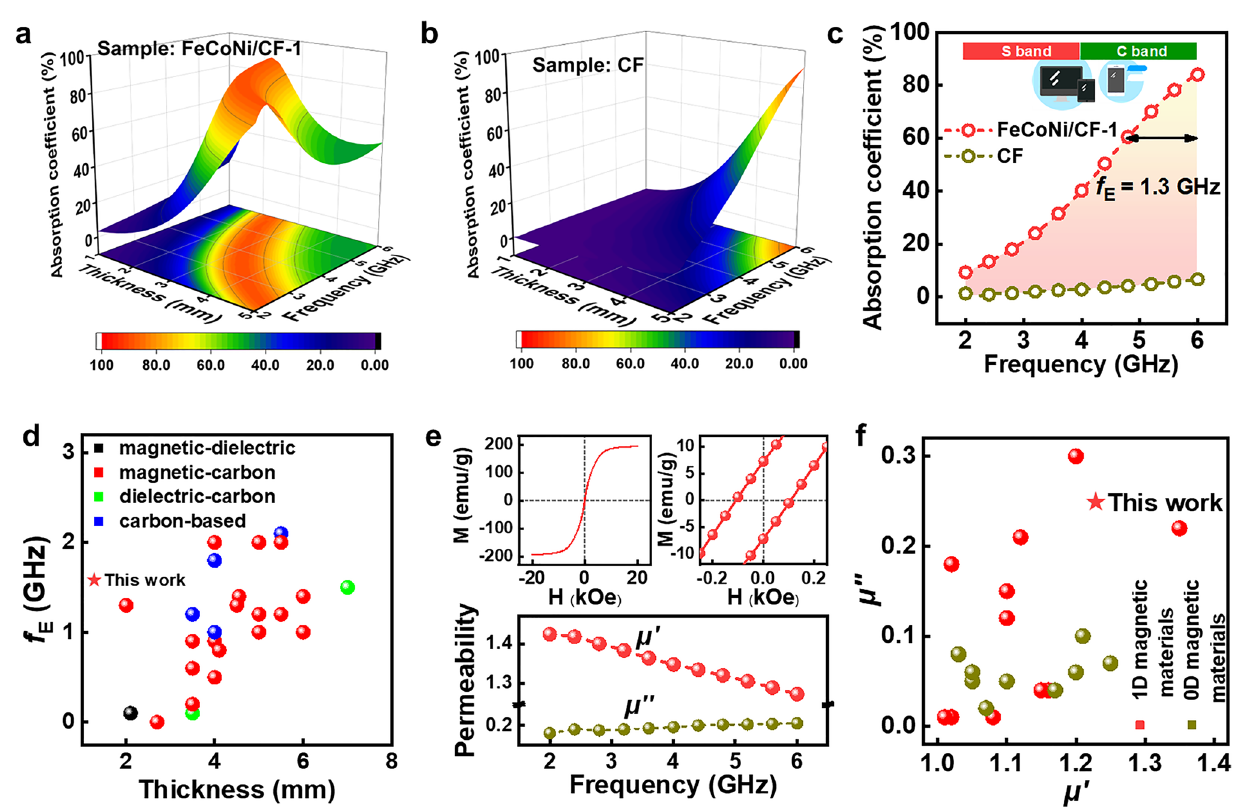
Fig. 3 3D absorption coefficient value mapping of a FeCoNi/CF-1 and b CF as a function of thickness ranging 1–5 mm. c The absorption coef- ficient of FeCoNi/CF-1 and CF at a thickness of 2 mm. d Low-frequency electromagnetic absorption performance of common absorbers, as concluded according to previous research. e Hysteresis loops and permeability of FeCoNi/CF-1. f Permeability comparison of related magnetic materials, as concluded according to previous